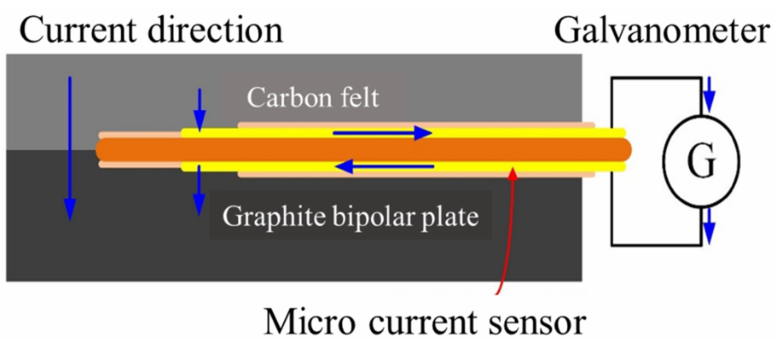
Figure 5. Schematic diagram of the principle of micro-current sensor.